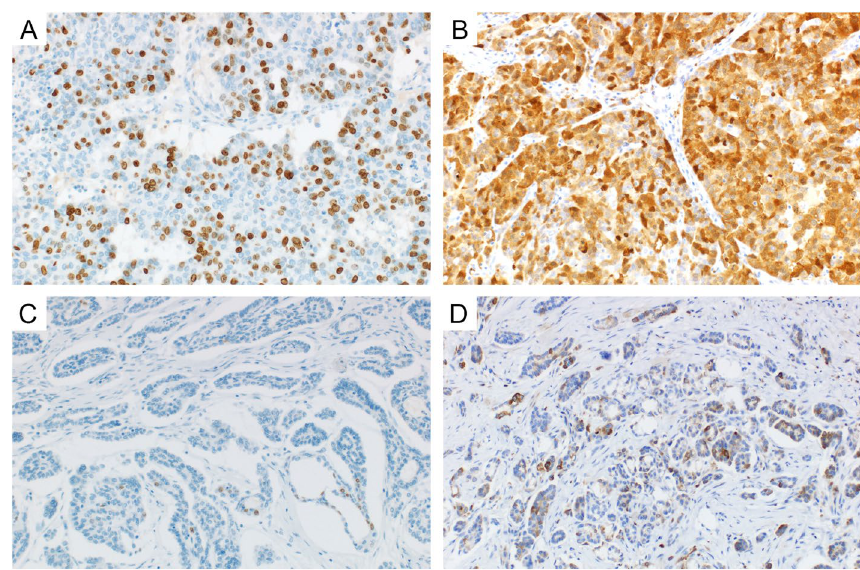
Fig. 1 Representative IHC staining of Ki67 and stathmin in HGSC and LGSC cases. A Expression of Ki67 in HGSC (200x), B Expression of stathmin in HGSC (200x), C Expression of Ki67 in LGSC (200x), D) Expression of stathmin in LGSC (200x). HGSC